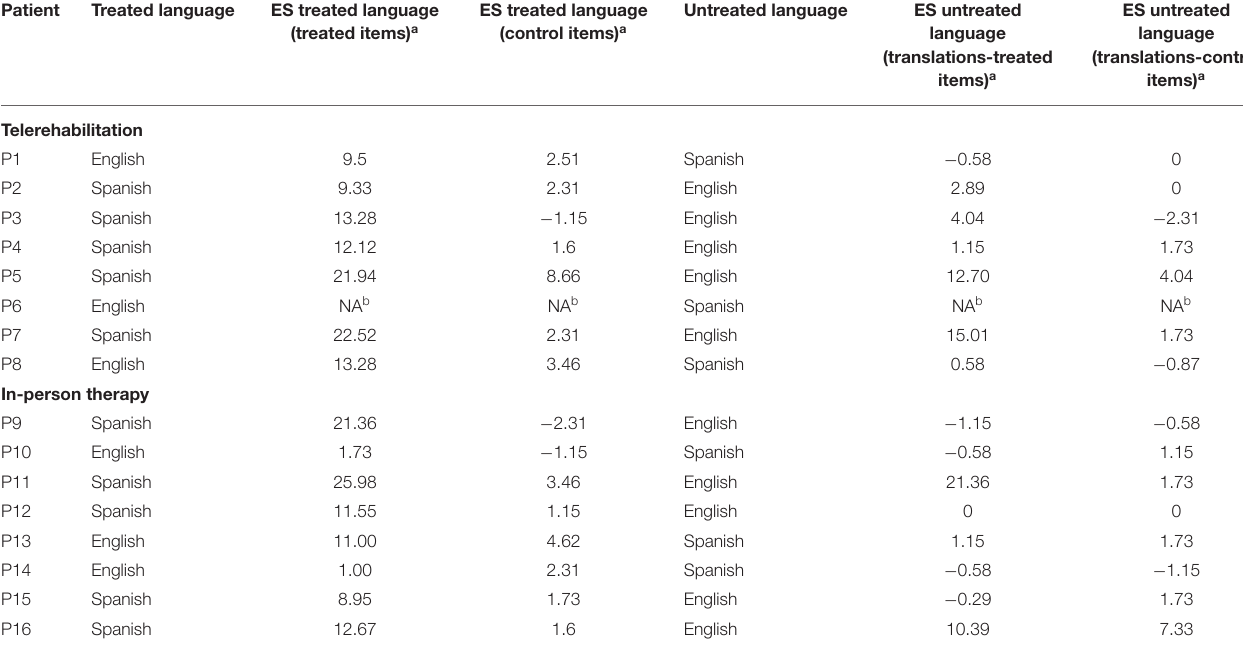
TABLE 4 | Treatment effectiveness as measured by effect sizes (ES) for the treated language and the untreated language across delivery modalities. Patient